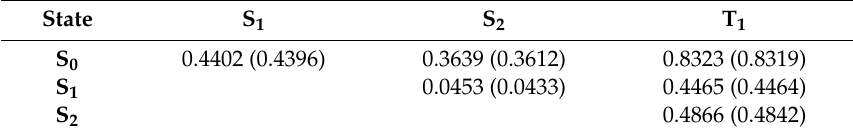
Table 5. Similarity indices d AB calculated at the CASSCF(6,6) / 6-311 ++ G(2d,2p) level for low-lying electronic states of C 6 H 6 . Values in brackets are π -only contributions to the total index.